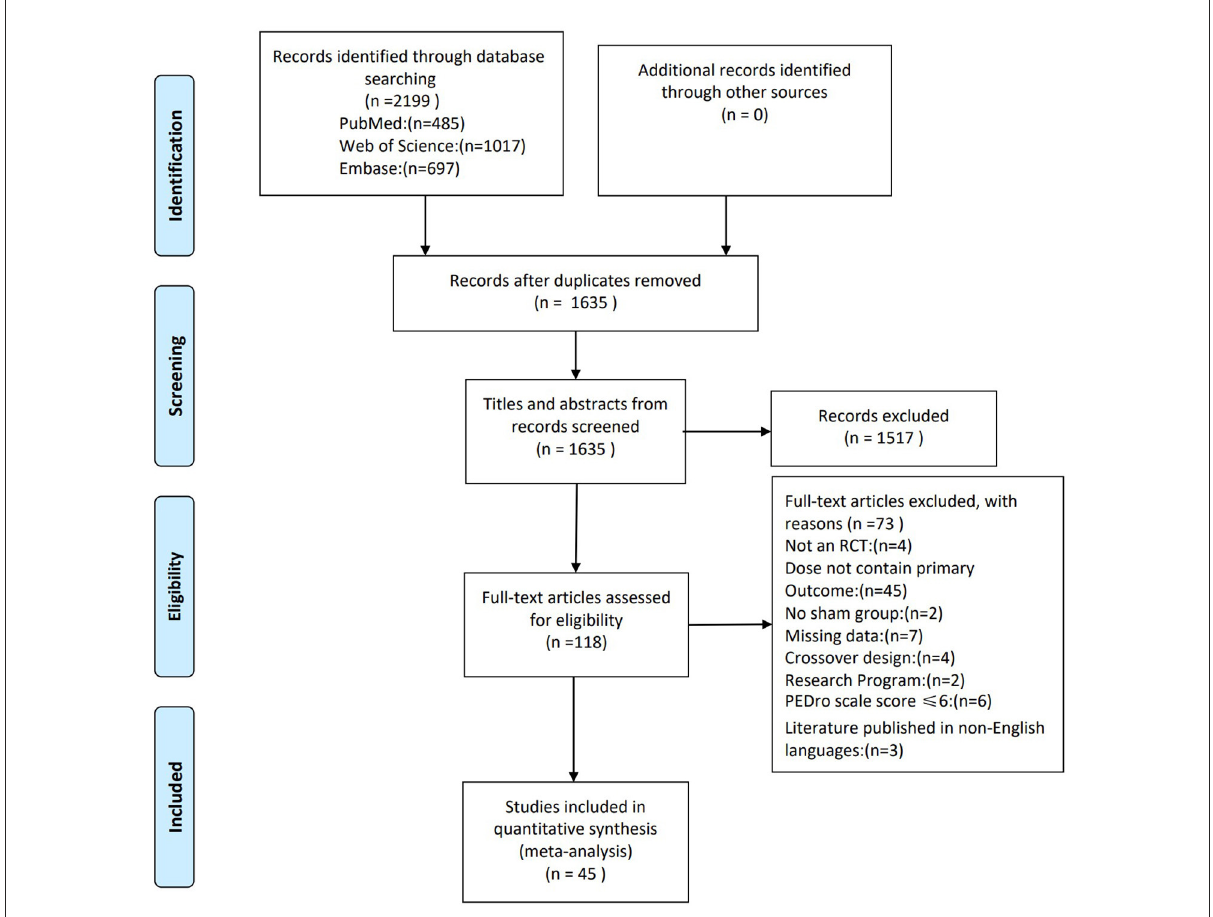
FIGURE1 PRISMA flow chart on selection and inclusion of